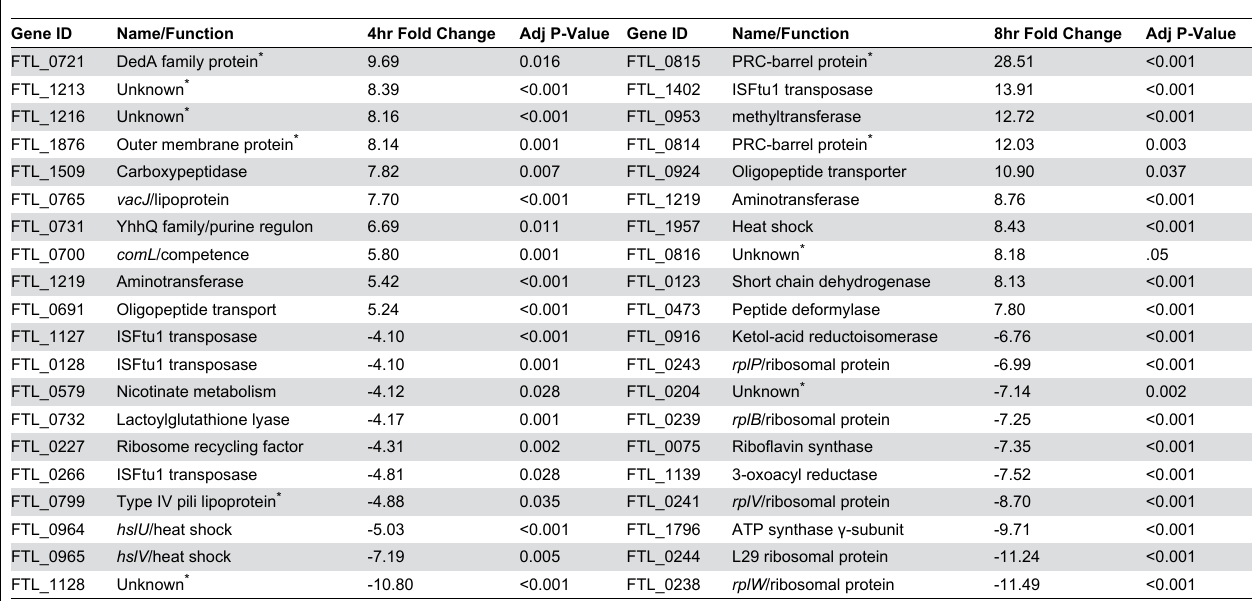
Table 1. Genes showing the largest changes in expression during